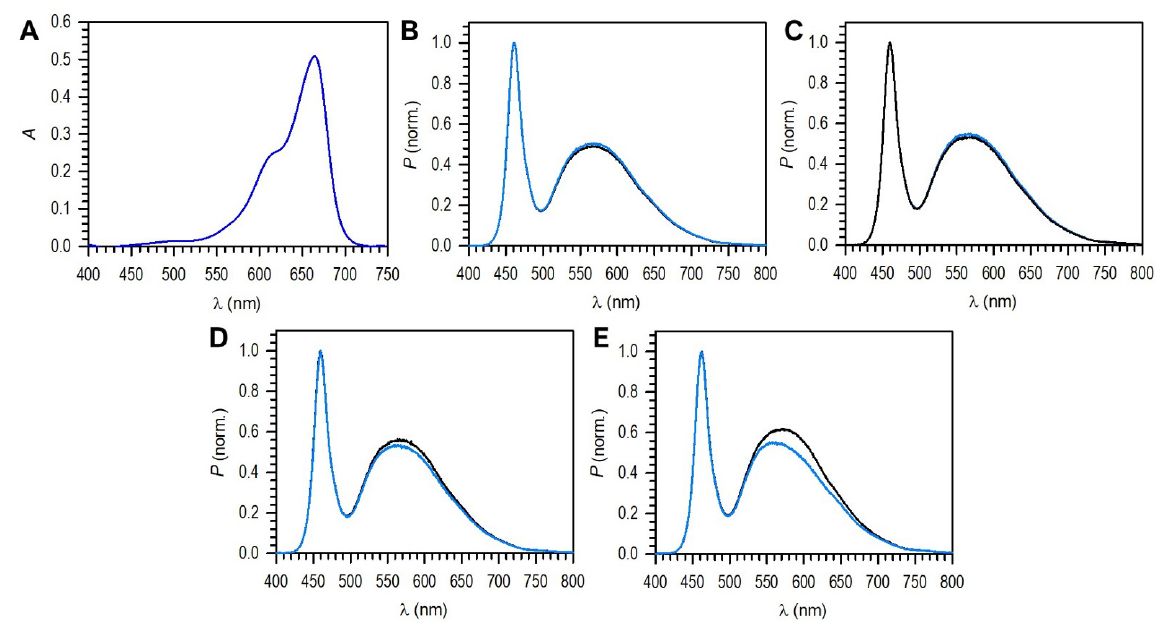
Figure 2. ( A ) Absorption spectrum of an aqueous solution of methylene blue 2.7 mg L − 1 recorded with a Varian Cary 3Bio spectrophotometer. ( B – E ) Normalized (at 455 nm) transmission spectra of the white LED-illuminated optical fibers subjected to the cladding dissolution process for 0 min ( B ), 20 min ( C ), 30 min ( D ) and 45 min ( E ) (blue lines) when dipped into a 2.7 mg L − 1 methylene blue solution; the black line represents the normalized spectra in the absence of methylene blue (spectral acquisition parameters: boxcar 0; 10-scan average; 36 ms integration